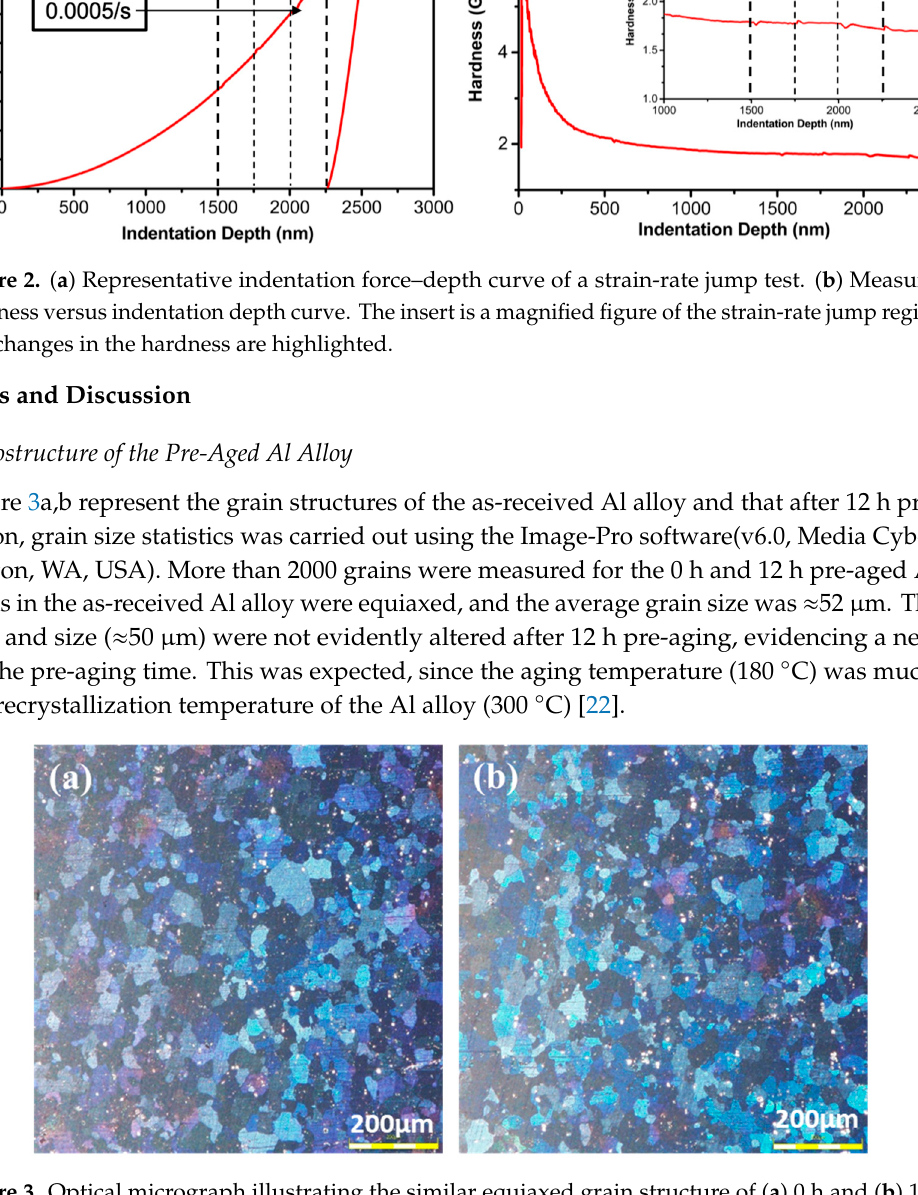
Figure 3. Optical micrograph illustrating the similar equiaxed grain structure of ( a ) 0 h and ( b ) 12 h pre-aged AA2524 alloy.